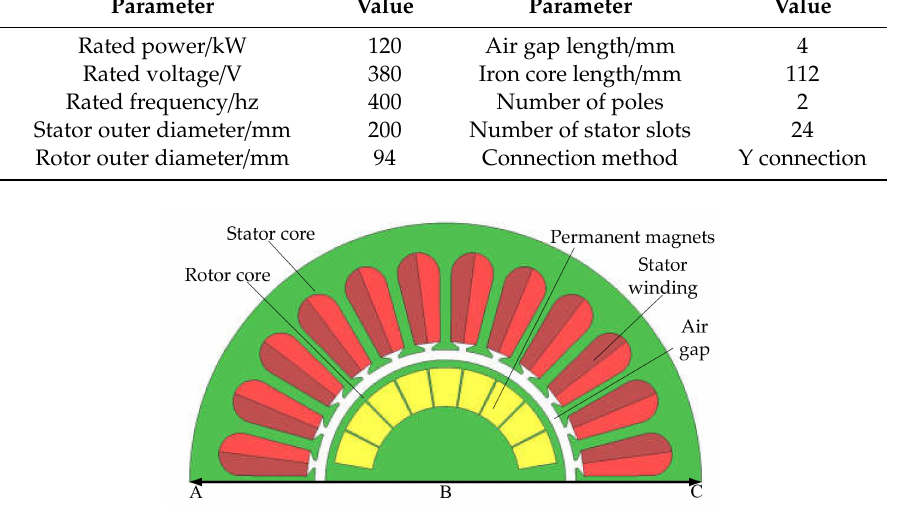
Figure 1. Solution domain physical